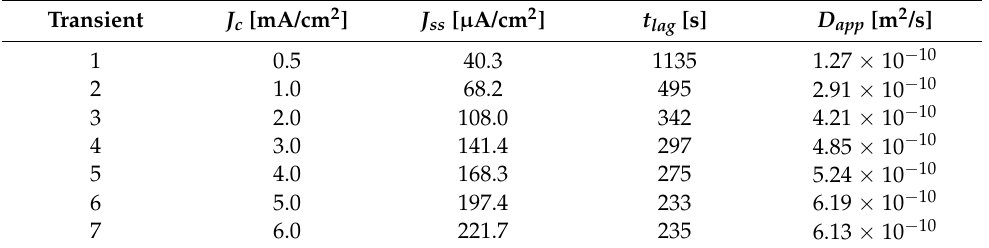
Table 5. Results obtained in the stepped permeation tests carried out on the QT700-7d grade.